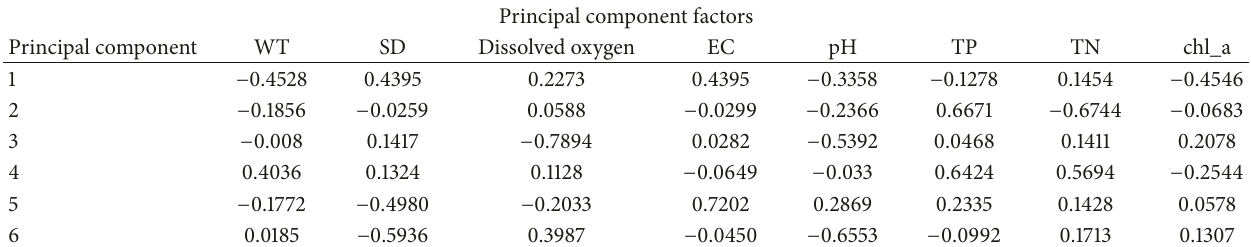
Table 6: Principal component analysis results for secondary